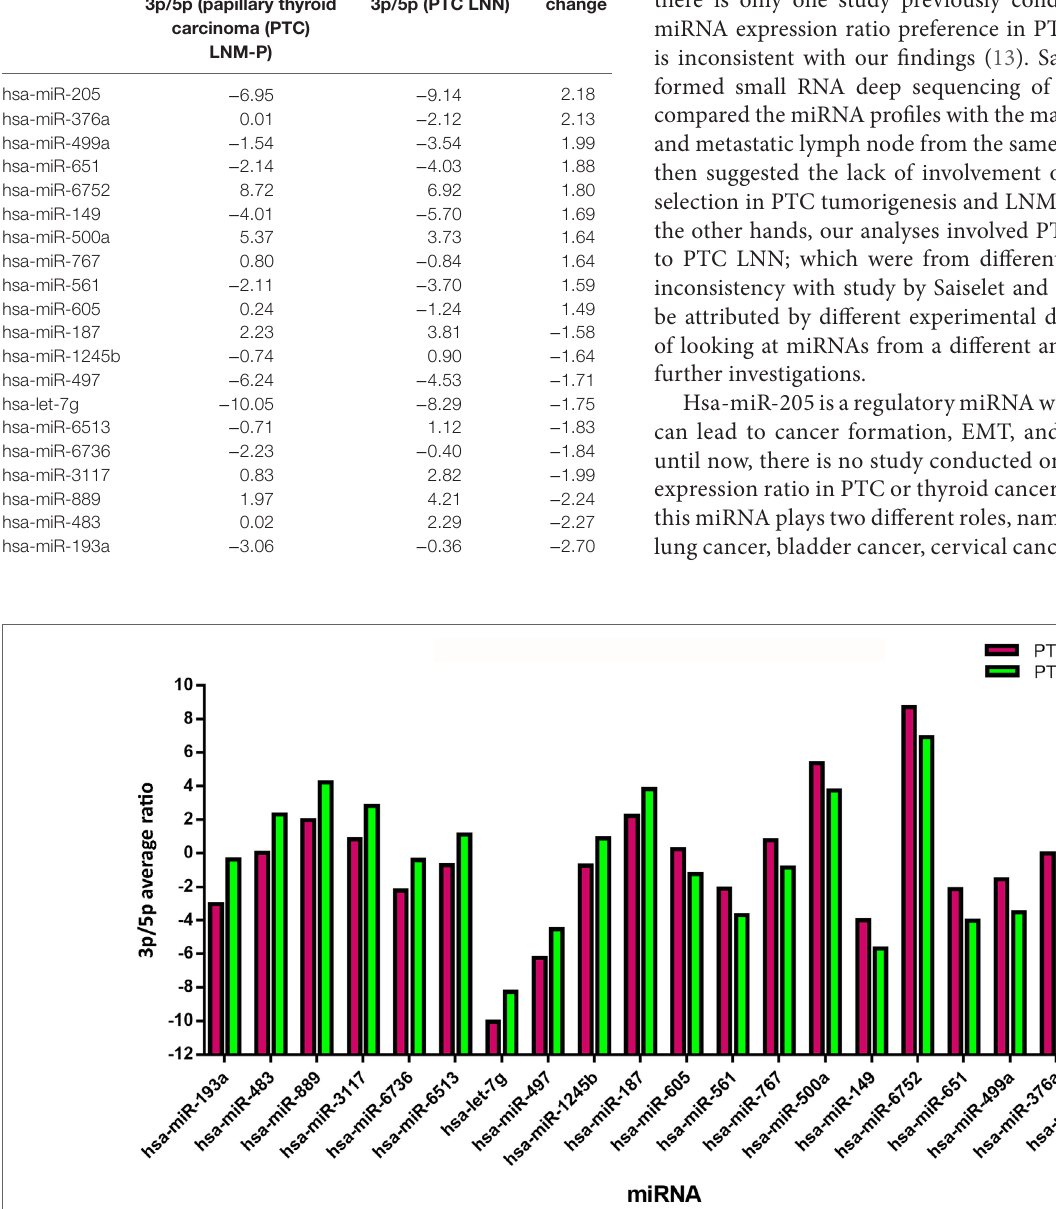
TaBle 2 | The list of top rank 20 microRNA (miRNA) with highest expression ratio.